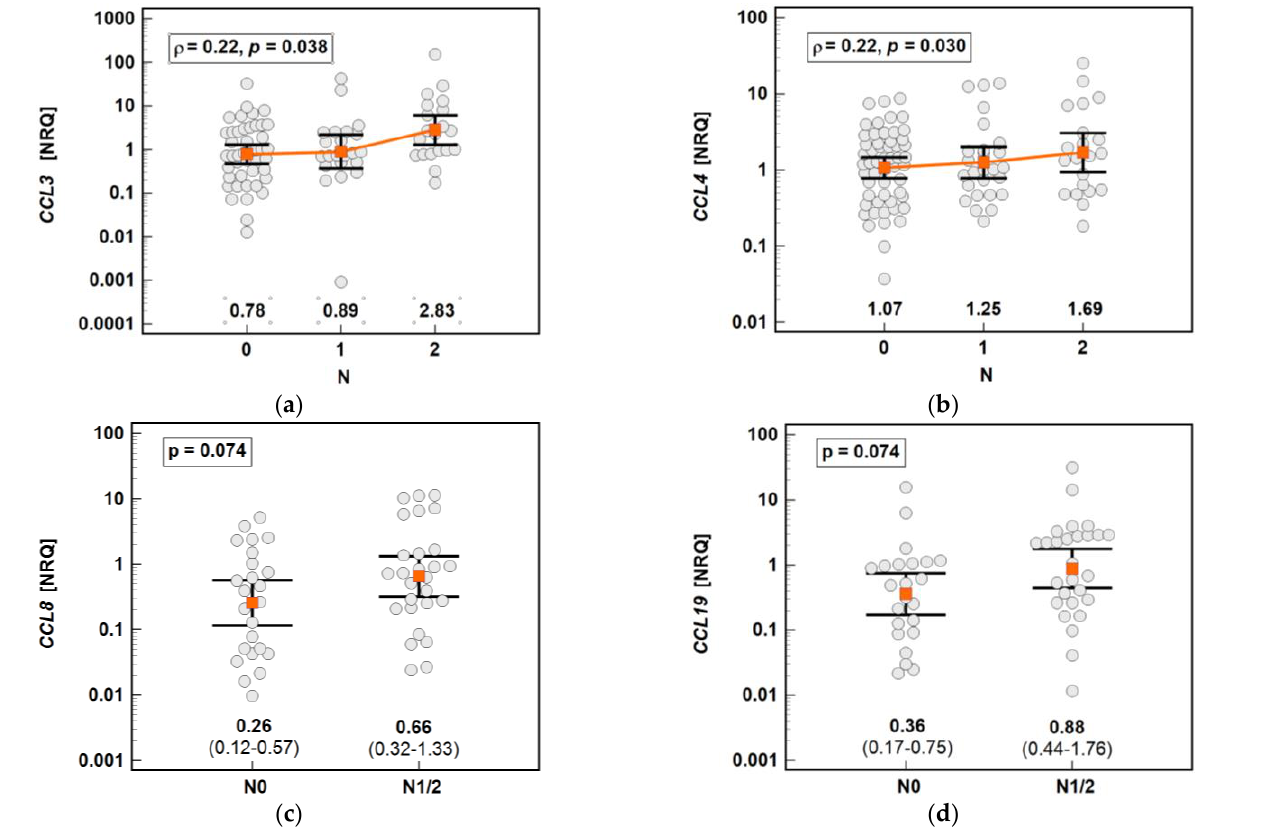
Figure 17. Impact of lymph node metastasis on the chemokine expression in tumors: ( a ) CCL3 ; ( b ) CCL4 ; ( c ) CCL8; ( d ) CCL19 . The data are presented as means with 95% confidence intervals, and as a Spearman correlation coefficient ( ρ ) ( CCL3 and CCL4 ). The data regarding CCL8 and CCL19 were analyzed using a t -test for independent samples. NRQ, normalized relative quantities.